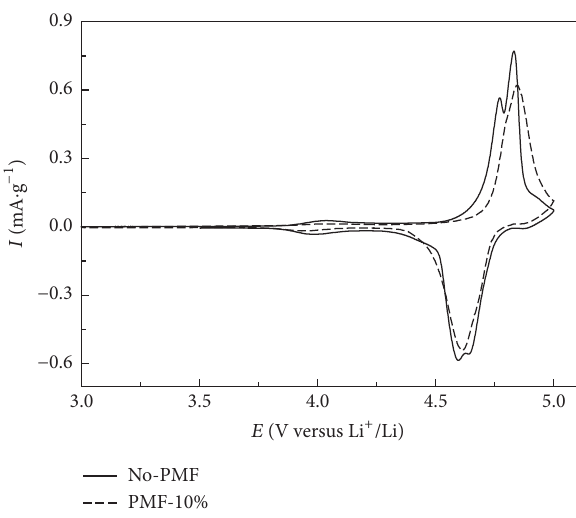
Figure 6: EIS spectra of prepared LiNi 0.5 Mn 1.5 O 4